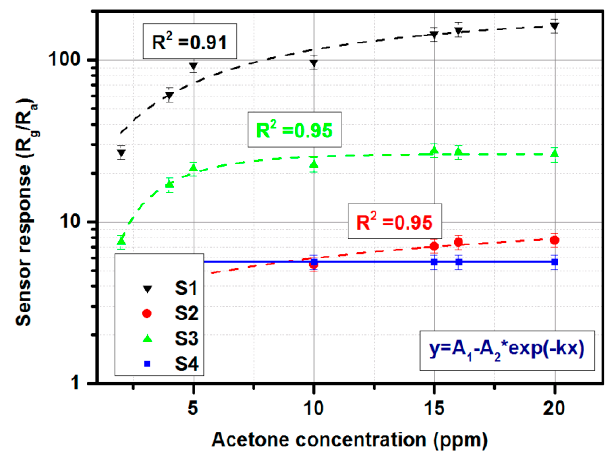
Figure 8. The calibration curves of all four sensors (S1–S4) in the gas sensor array under exposure to 2–20 ppm of acetone. Optimal operating temperature (given by the manufacturer) was ensured and 50% relative humidity was stabilized.